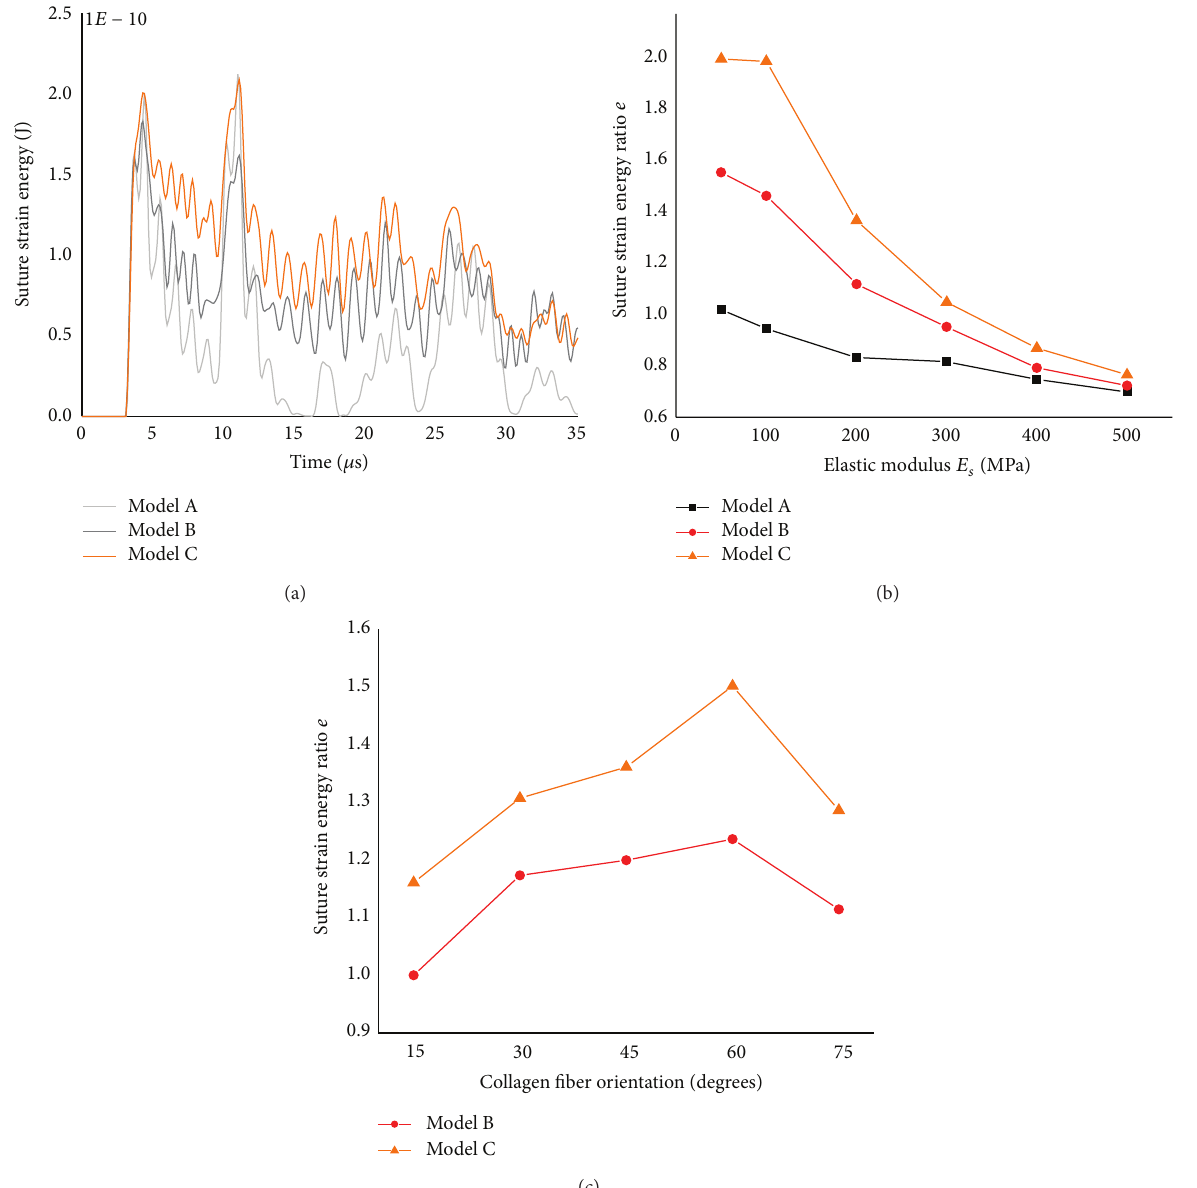
Figure 9: Suture strain energy for different suture models: (a) time history of the strain energy, (b) the influence of suture elastic modulus on the suture strain energy ratio, and (c) the influence of collagen fiber orientation on the suture strain energy ratio.